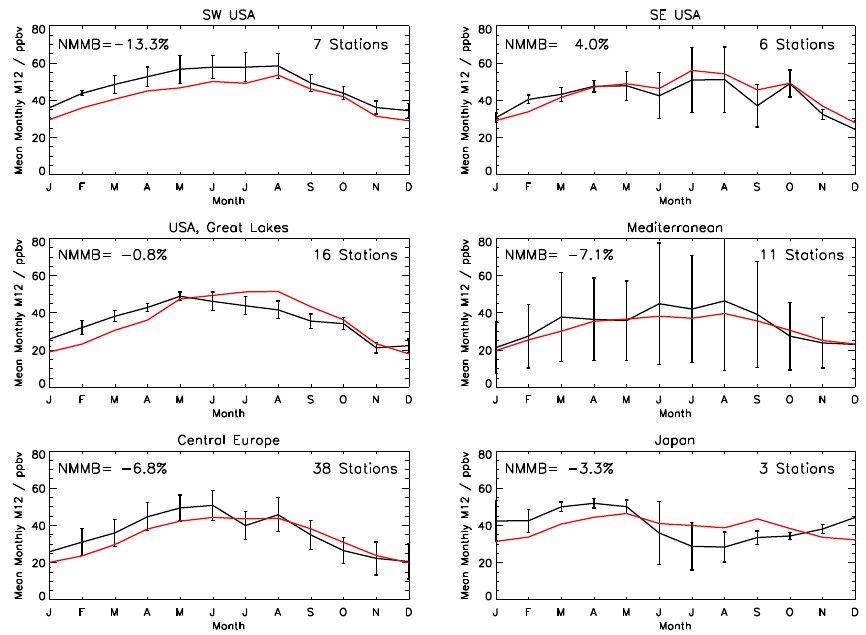
Fig. 4. As Figure 3, but for the monthly-average M12 metric (see main text for definition).